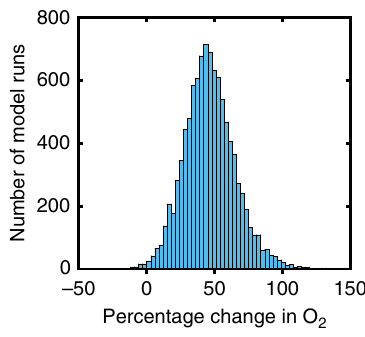
Fig. 6 Probability distribution of surface O 2 reservoir change. Probability 560 – 540 Ma for Monte-Carlo ensemble. The mean O 2 value is taken